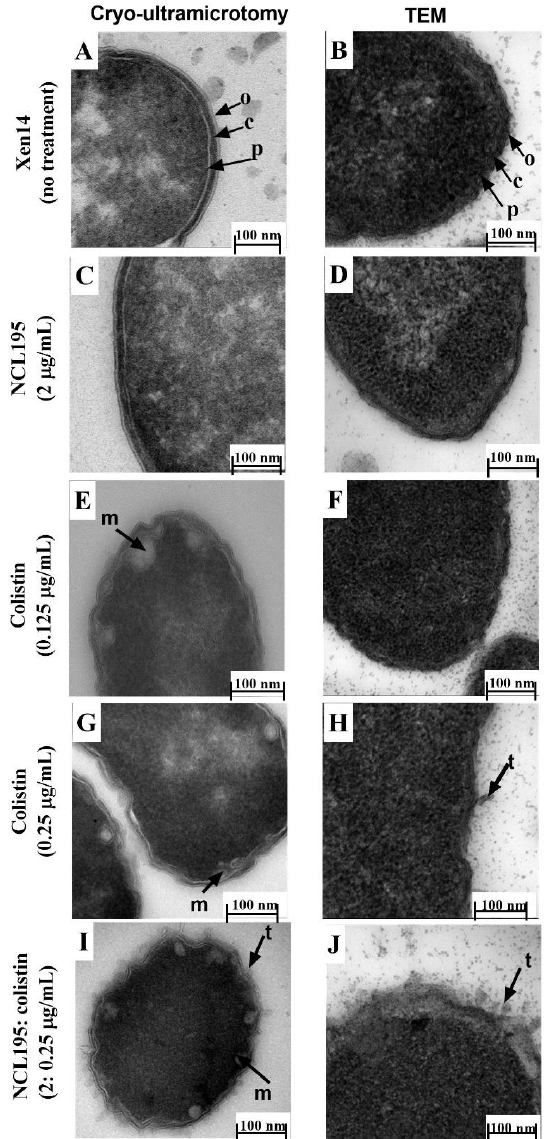
Figure 7. Comparison of Xen14 cells with and without antibiotic treatment and processed by Tokuyasu cryo-ultramicrotomy vs. conventional TEM. Approximately 5 × 10 8 cells were treated for 1 h; Xen14 cells. Cryo-ultramicrotomy images are indicated on the left, corresponding TEM images on the right. ( A ) vs. ( B ) cells without treatment; ( C ) vs. ( D ) treatment with NCL195 at 2 µ g/mL showing no effect of NCL195 treatment on cell morphology; ( E ) vs. ( F ) cells treated with colistin at 0.125 µ g/mL; ( G ) vs. ( H ) cells treated colistin 0.25 at µ g/mL; ( I ) vs. ( J ) group exposed to colistin 0.25 at µ g/mL + NCL195 at 2 µ